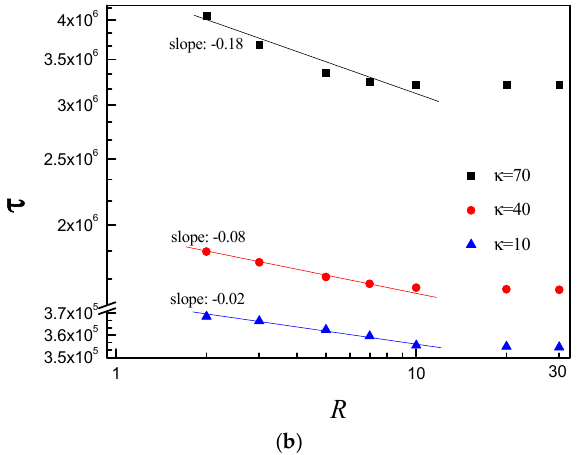
Figure 2. τ vs. the separation distance R between two flat membranes for: ( a ) N = 75, E = 2.5; and ( b ) N = 150, E = 5.0. Here, κ is the bending stiffness which can describe the stiffness of polymer chain. Data from R = 2 to 10 is plotted in log–log scale in Origin, and then the slope is obtained by the linear fit. The solid line is the linear fit of data from R = 2 to 10.